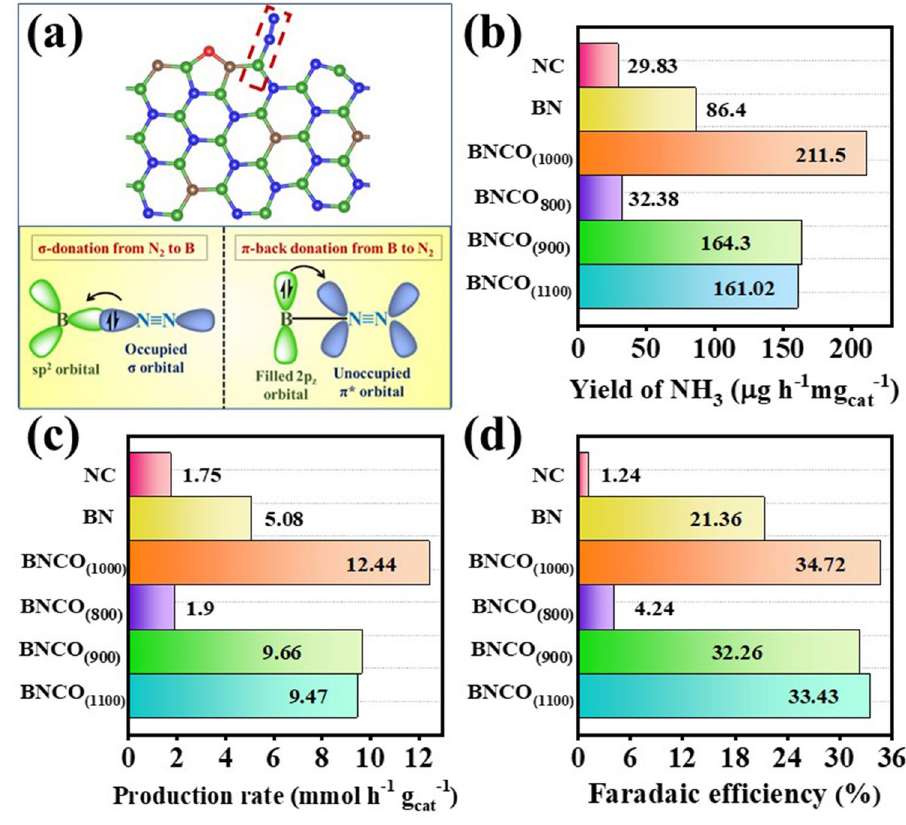
Fig. 5 a Energy optimized structures of the BNCO (1000) catalyst with N 2 adsorbed on the edge B site and the molecular orbital interaction between B and ad-N 2 . Comparison in NRR performance of all the synthesized catalysts in 0.1 M HCl at -0.1 V vs RHE in terms of b yield of NH 3 , c mass-normalized production rate and d Faradaic